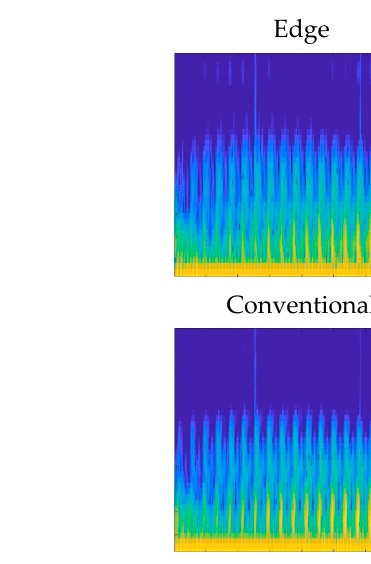
Figure 7. STFT spectrograms of the solid test specimens.